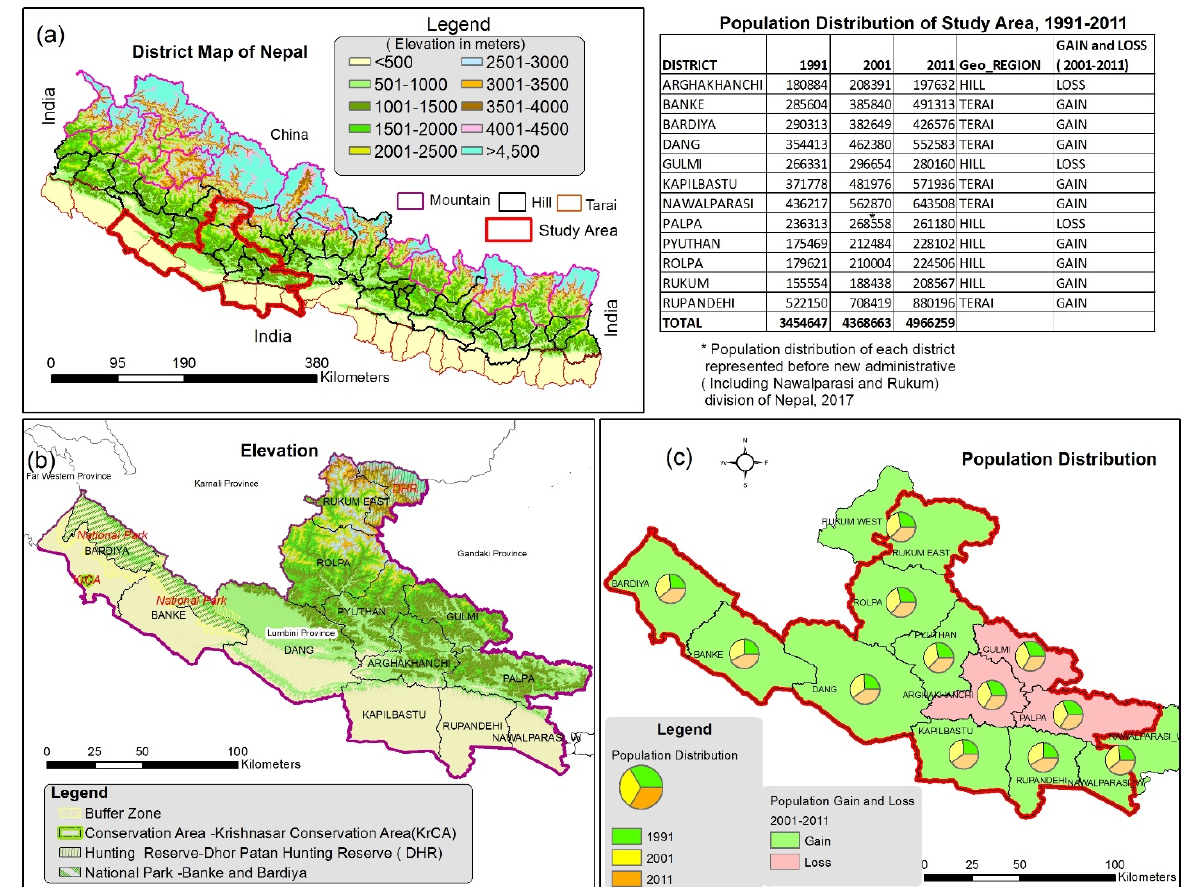
Figure 1. Location of the study area.